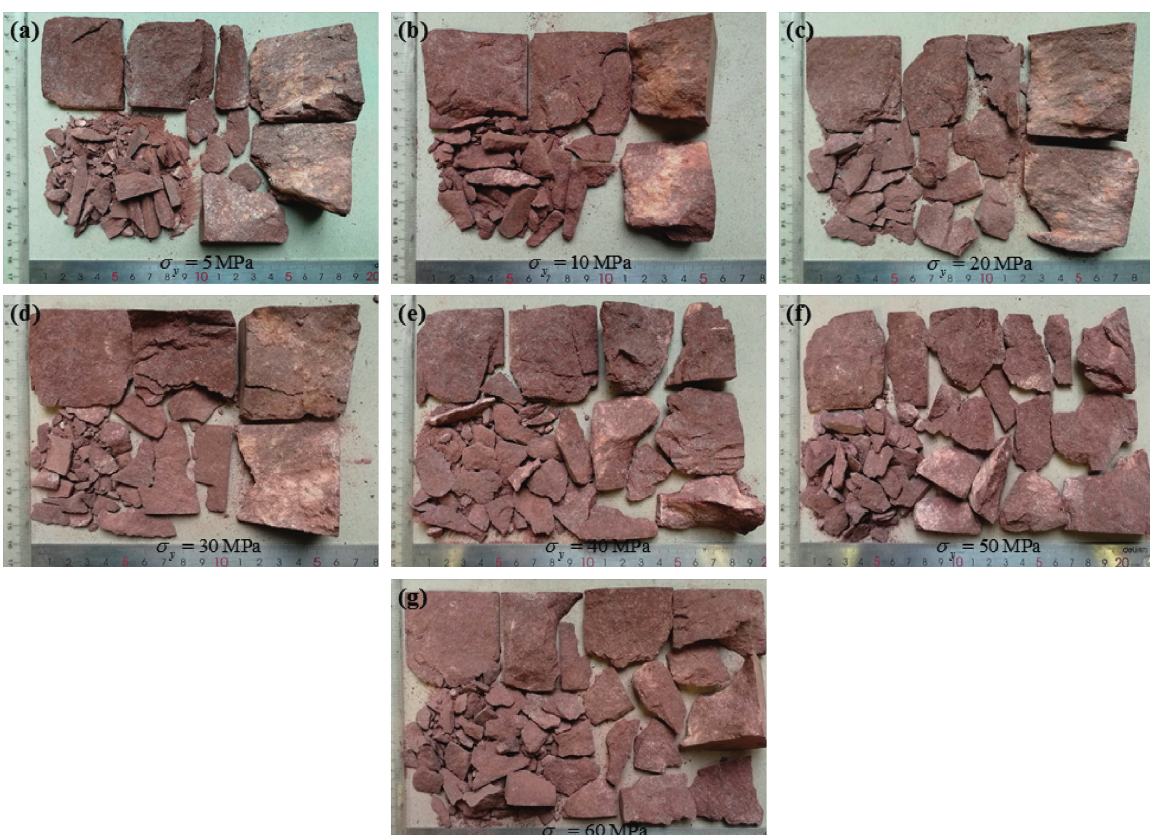
Figure 9: Failure characteristics of BCT at different confining